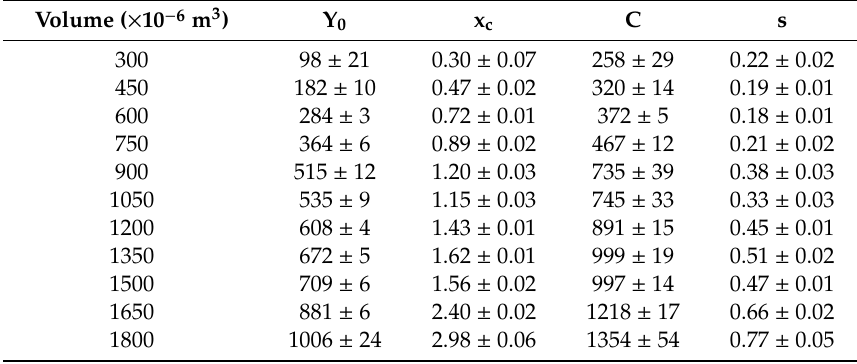
Table 4. Parameters of convergence of non-linear adjustment applied to the